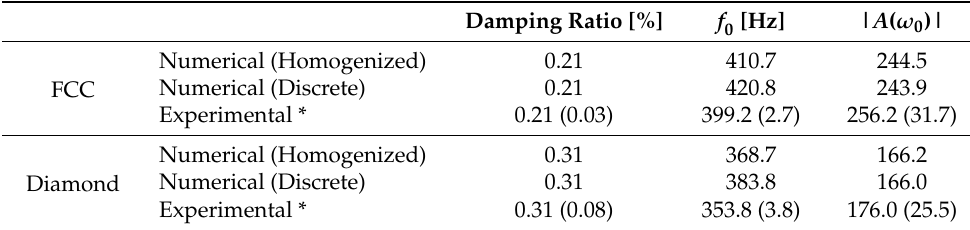
Table 4. First natural frequency and FRF of the numerical models and the results of the sweep tests.